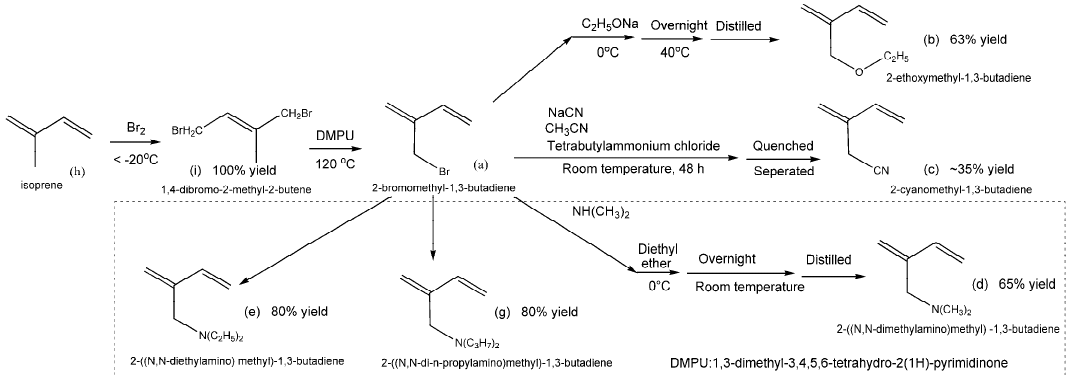
Figure 11. Synthesis of functionalized 1,3-butadiene using 2-bromomethyl-1,3-butadiene [135–144].